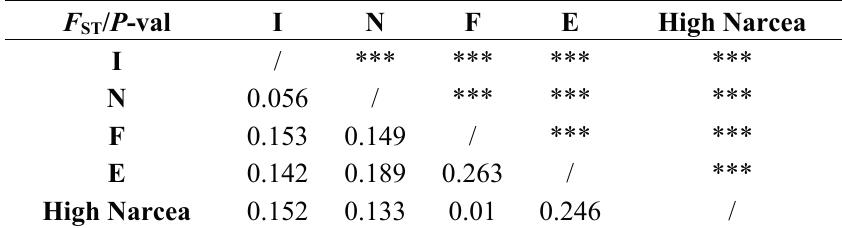
Table 4. Pairwise F ST values (below diagonal) and their statistical significance (above diagonal) between the studied hatcheries and the wild individuals of the High Narcea. *** <0.001. F / P -val ST